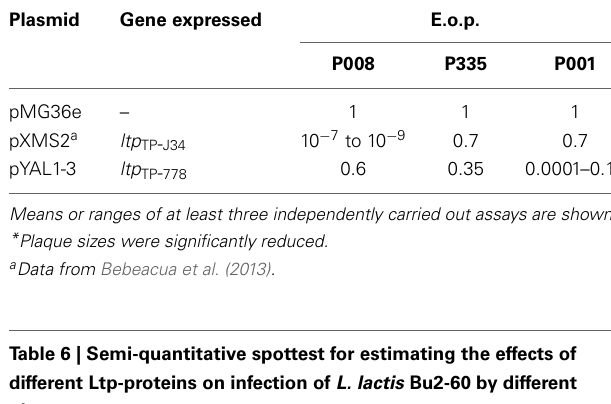
Table 5 | Plating efficiencies (E.o.p.) of lactococcal phages on L. lactis Bu2-60 expressing plasmid-encoded copies of ltp TP - J34 or ltp TP - 778 . Plasmid